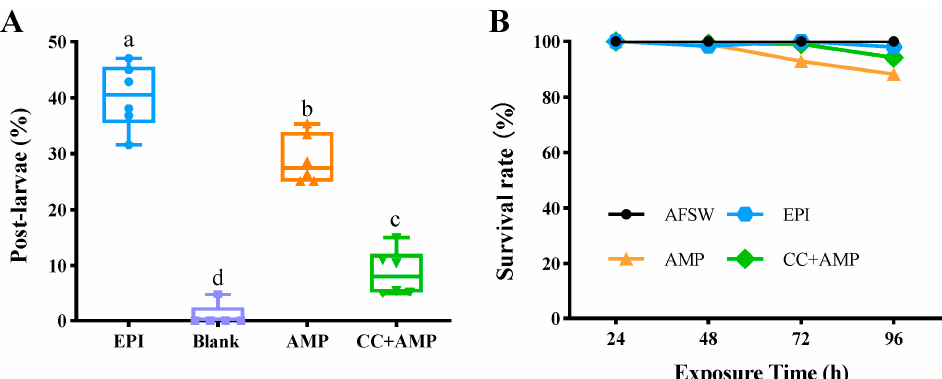
Figure 10. The larval metamorphosis and survival rate of M. coruscus at 72 h after being treated with AMPK inhibitors. ( A ) The rate of post-larvae. ( B ) The survival rate at different times.